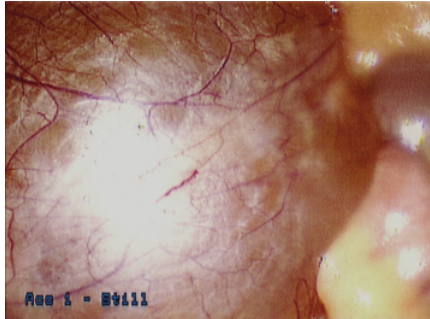
Figure 3: An intraoperative laparoscopic image reveals the outer capsule of the mesenteric cyst, with surface vascularity.